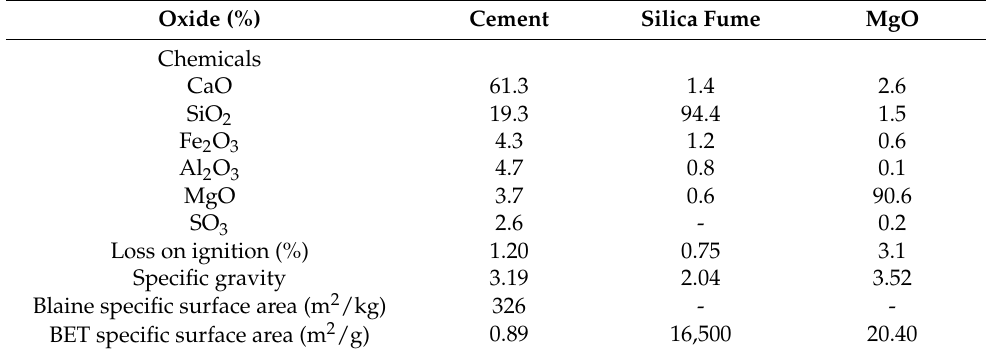
Table 1. The chemical oxides and physical property of cement, silica fume and MgO.